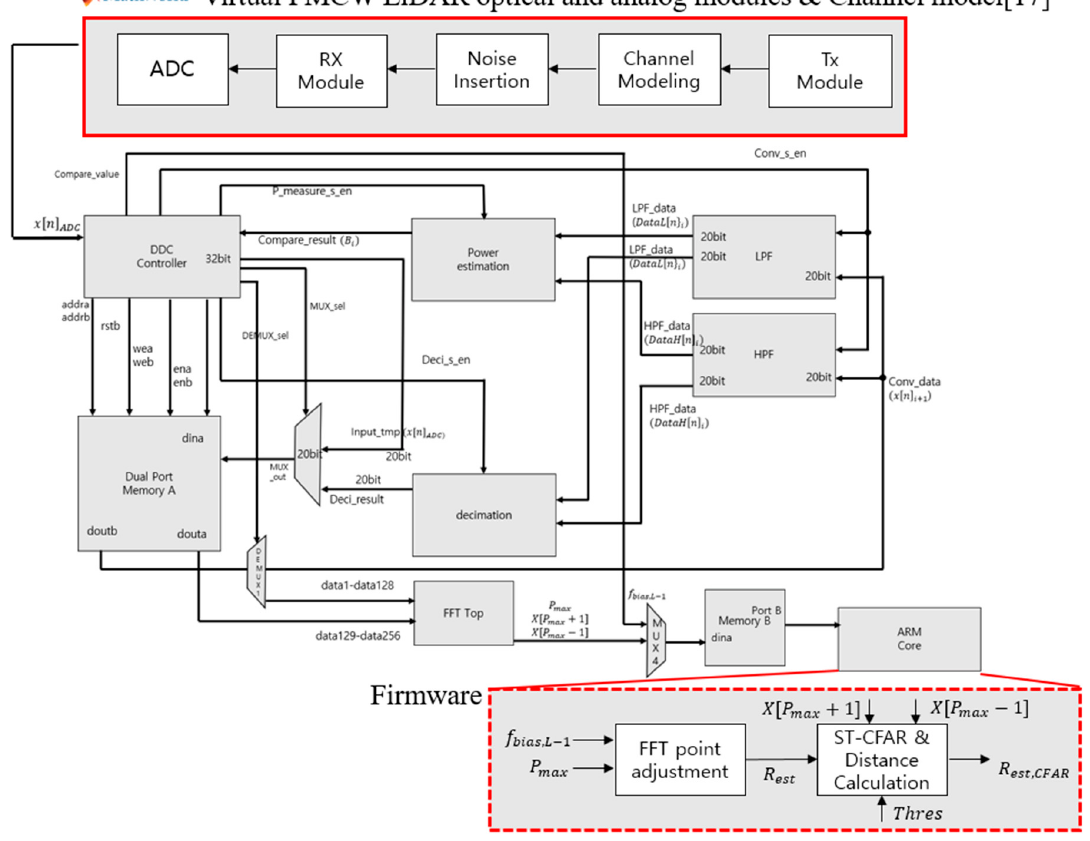
Figure 7. Hardware Implementation Block Diagram.